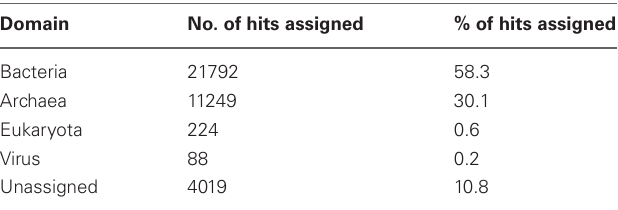
Table A1 | Taxonomic information based on assigned blastx results to each